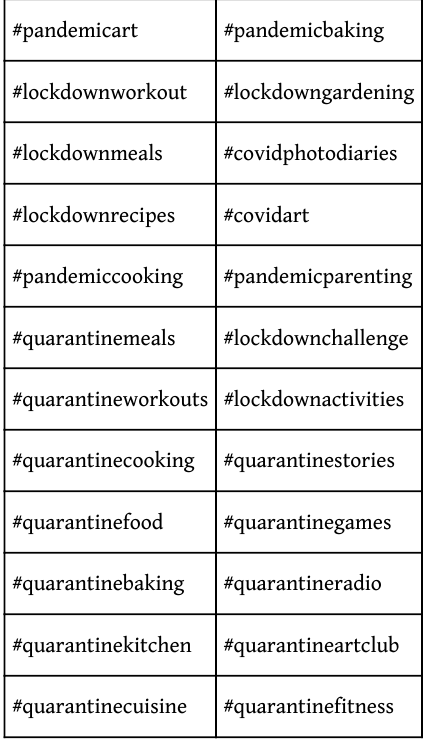
#pandemicart #pandemicbaking